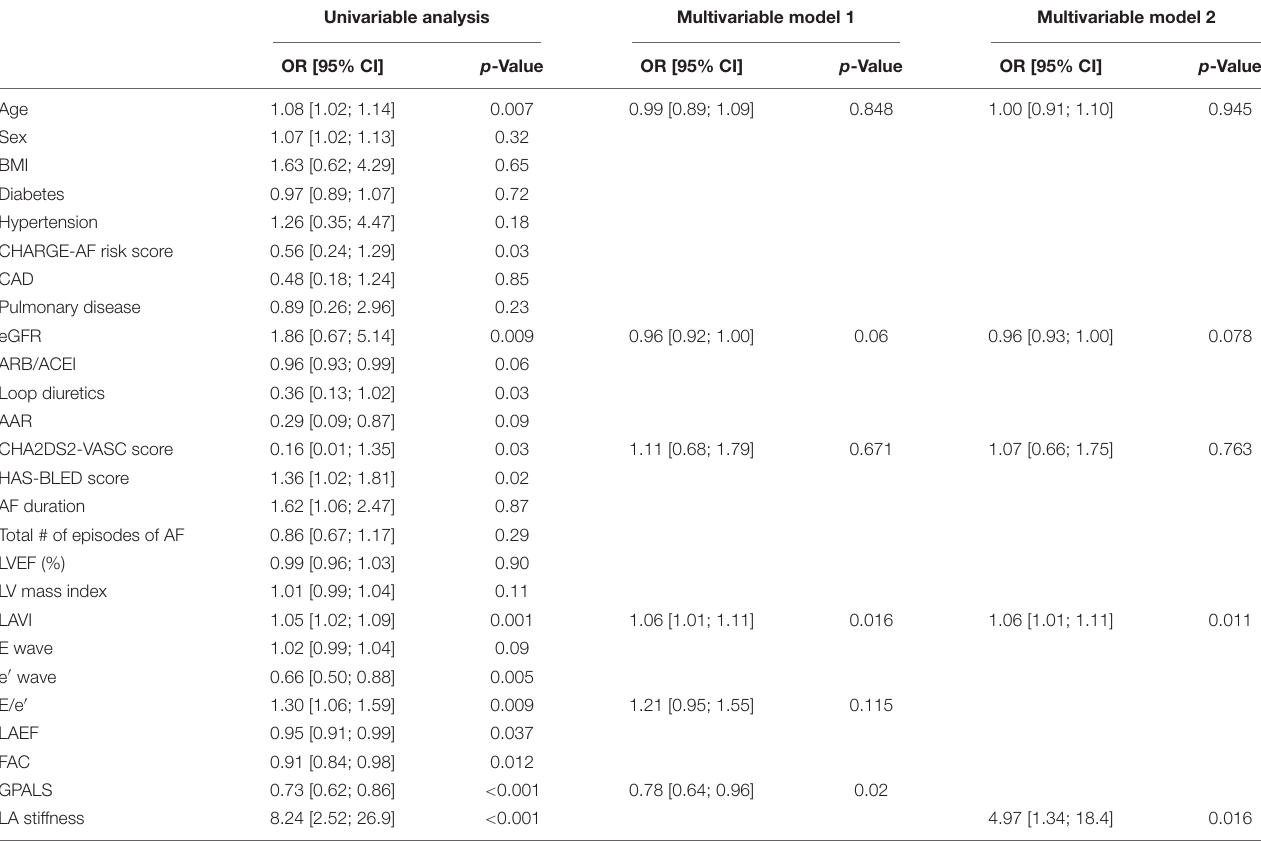
TABLE 3 | Uni- and multivariable logistic regression analysis for predictors of